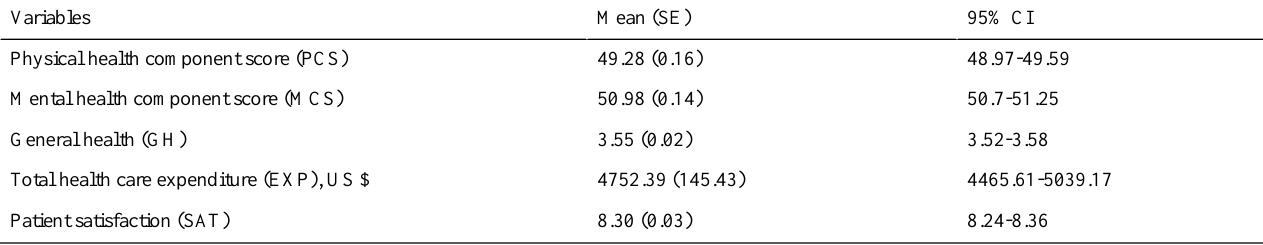
Table 3. Descriptive statistics for medical expenditure, outcomes, and patient satisfaction.